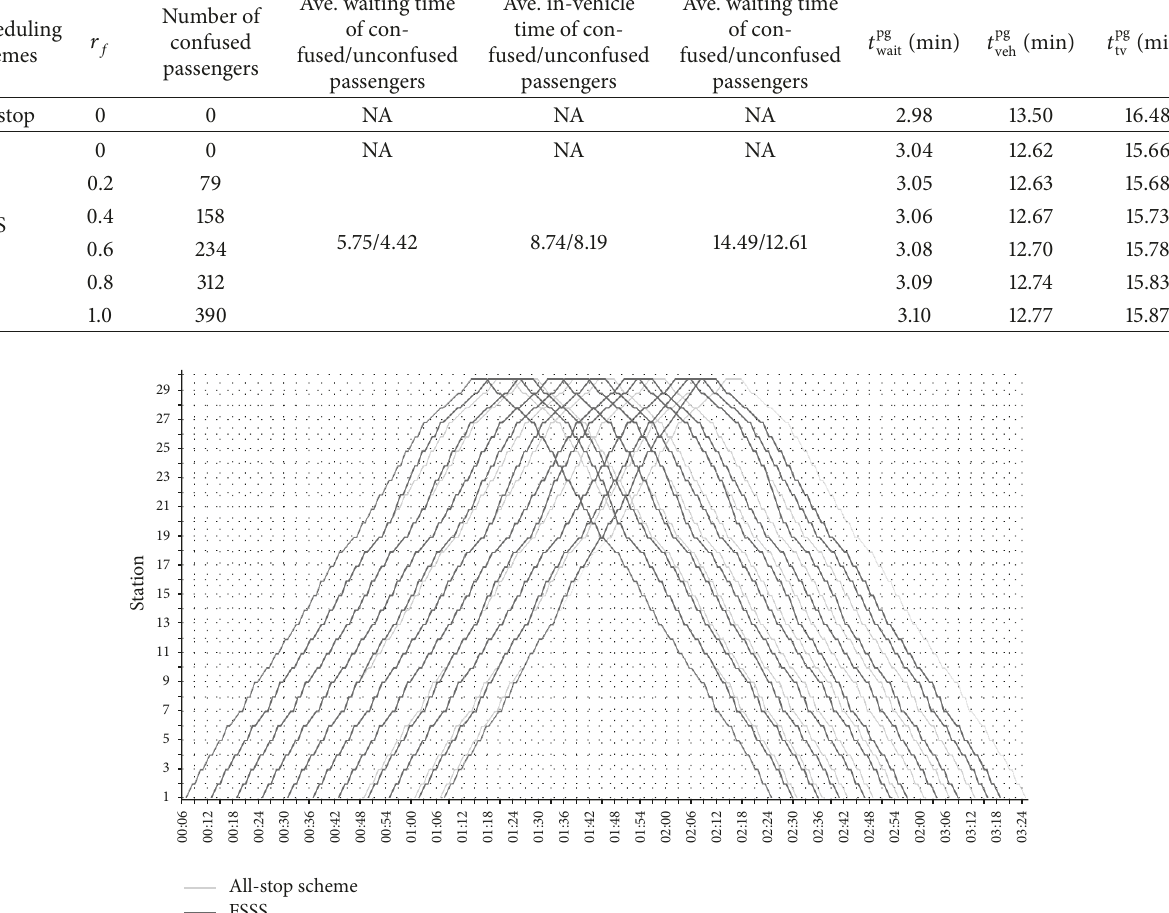
Figure 8: Timetables of all-stop scheme and